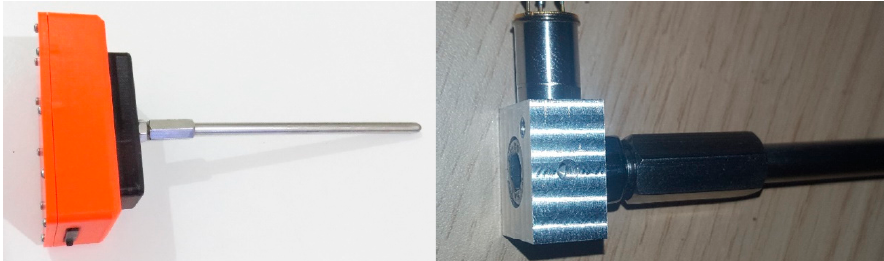
Figure 2. ( left ) The vibrations recorder: a rugged container for outdoor deployment contains the electronics including GPS and GPRS, ( right ). Detail of the metal waveguide fastened to the input of the accelerometer. The tree trunk is first drilled using a bit matching the size of the probe and the waveguide is subsequently inserted and fastened in the hole.